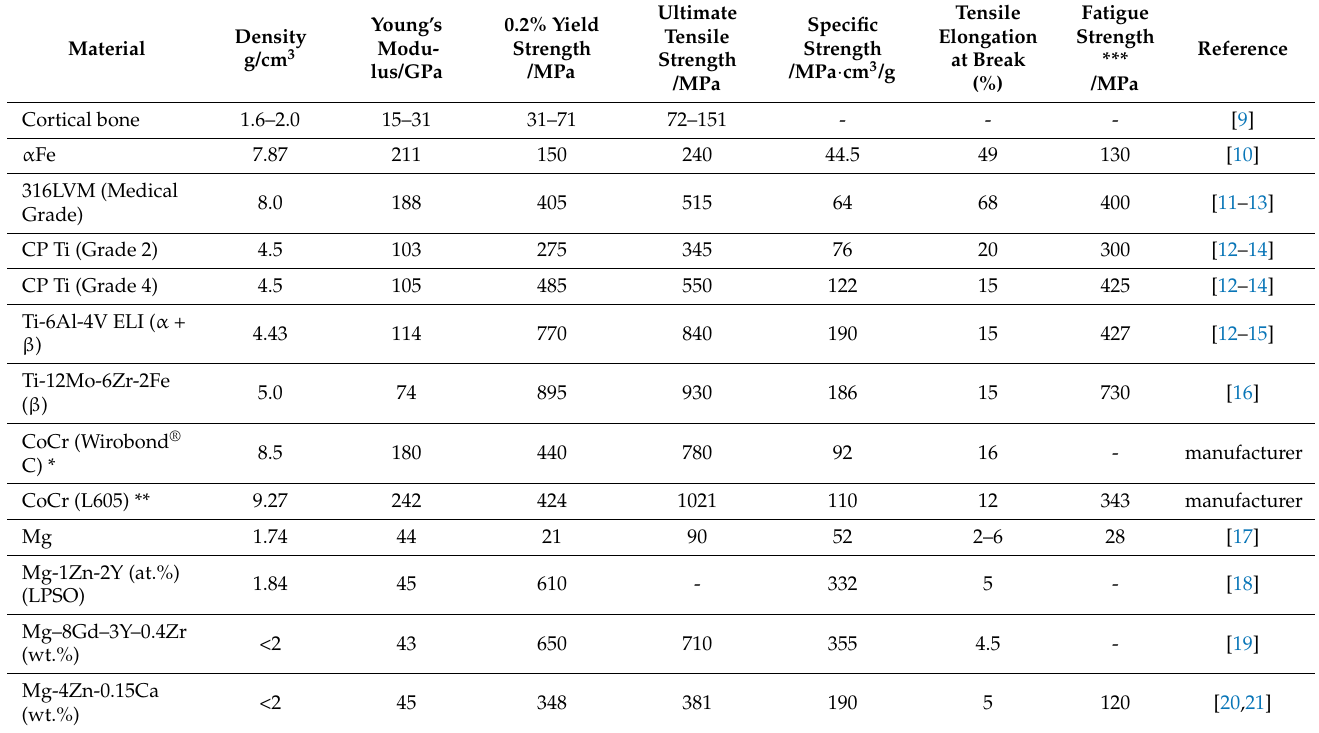
Table 1. Typical Properties of Implant